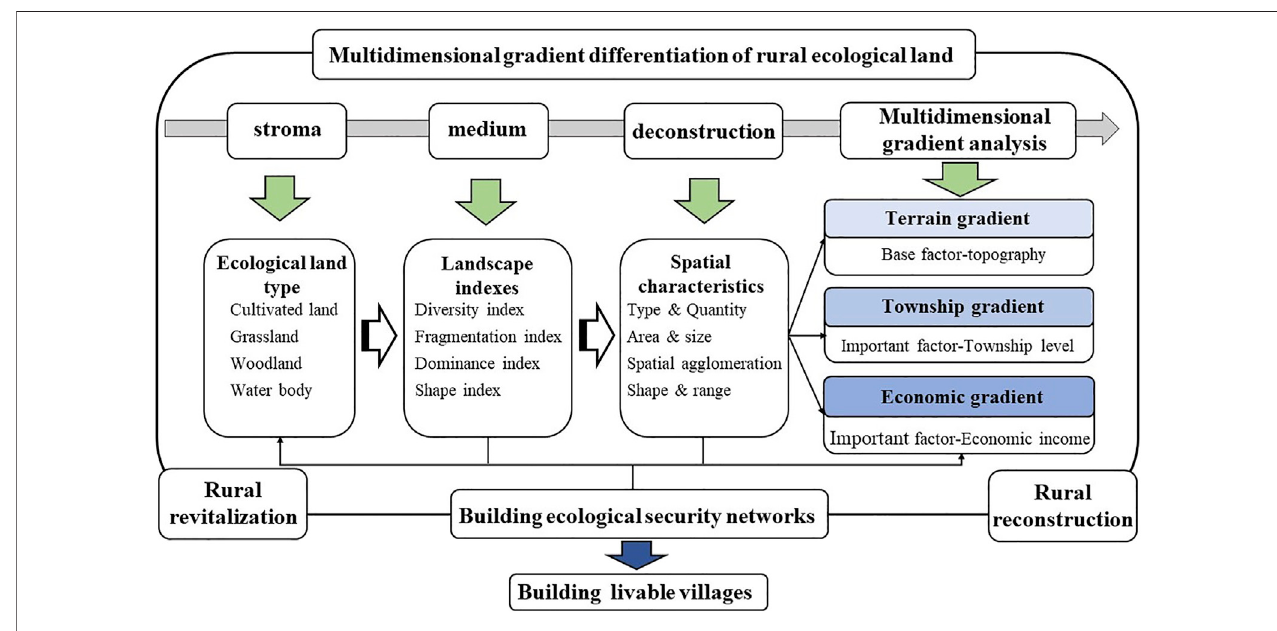
FIGURE 2 | The research framework of REL.